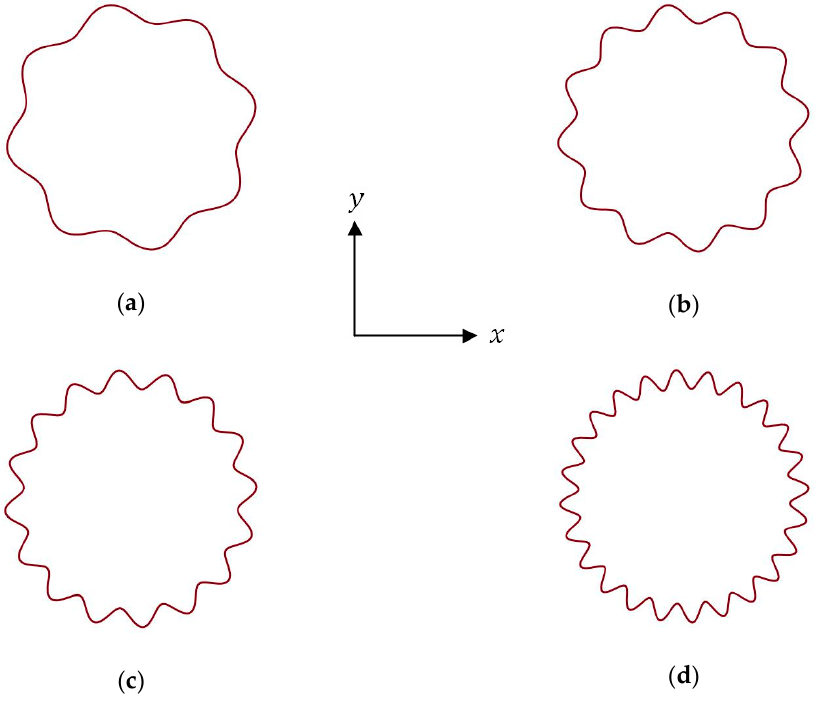
Figure 2. Cross sections of the duct for different numbers of corrugations: ( a ) 𝑁 = 8 ; ( b ) 𝑁 = 12; ( c ) 𝑁 = 16 ; ( d ) 𝑁 = 24.